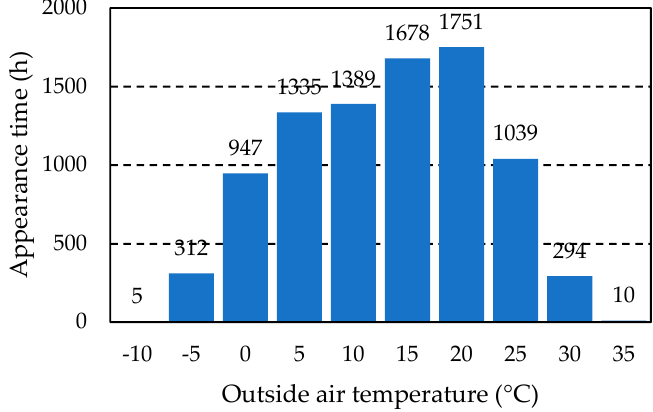
Figure 16. Durations of outside-air temperature in 5 °C increments (data for Tokyo).